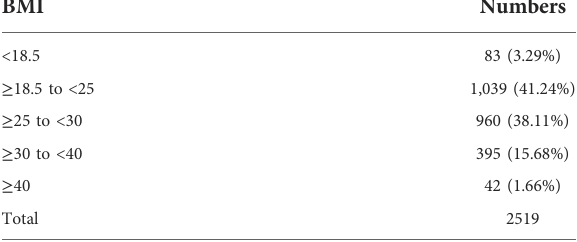
TABLE 5A Patient ’ s pro fi le depending on the type and indication of previous gynae